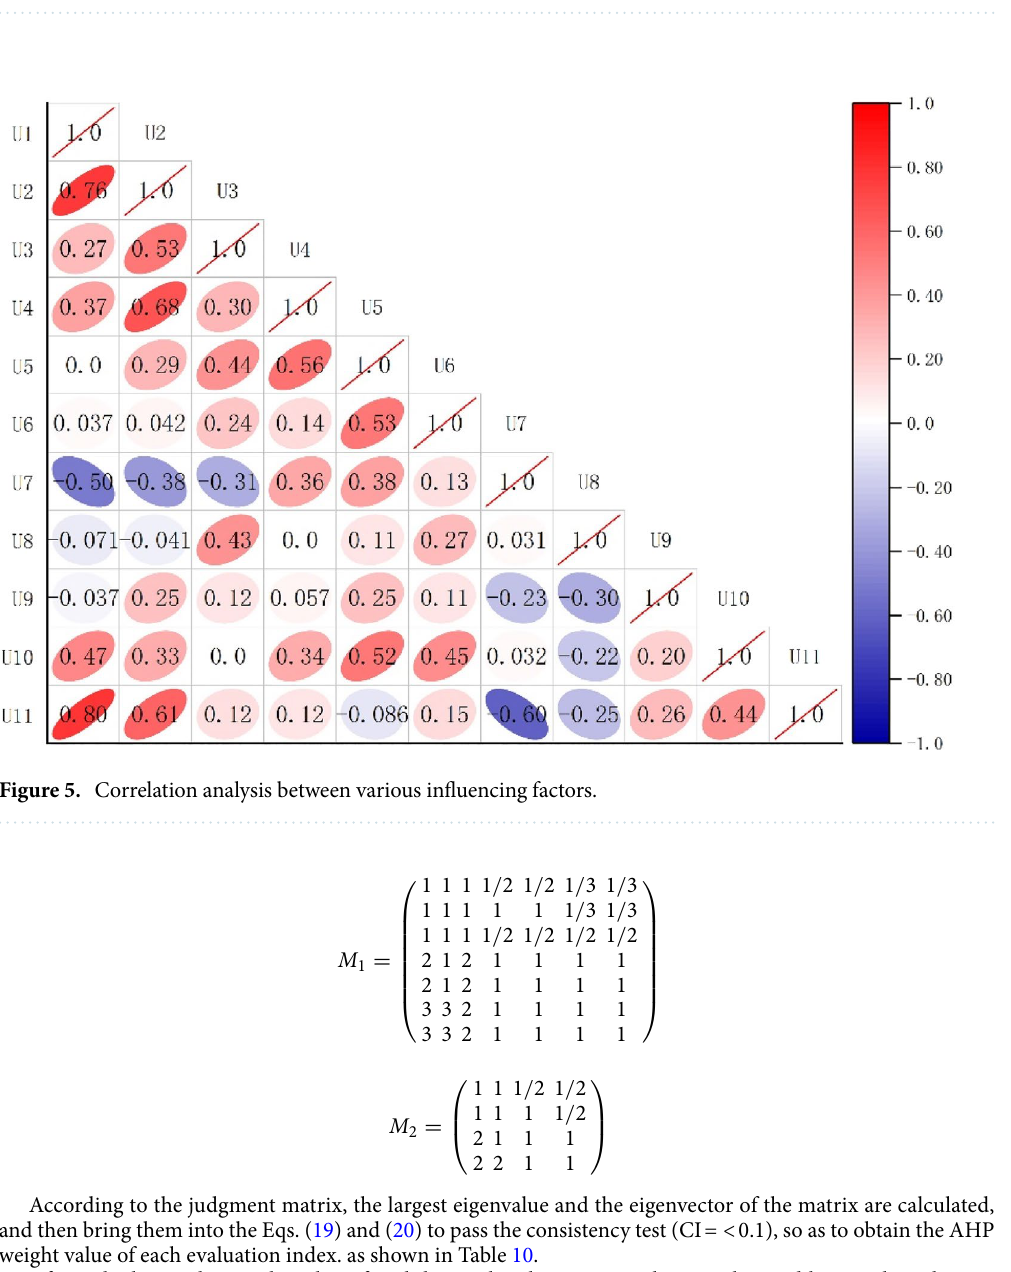
Table 6. Spatial distance of influencing factors of each sample.